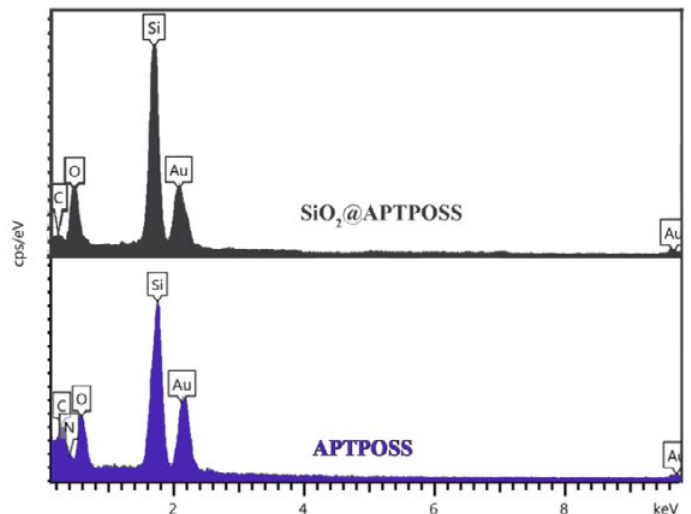
Fig. 3. Energy dispersive spectroscopy for APTPOSS and nano-colloidal silica Fig. 3 . Energy dispersive spectroscopy for APTPOSS and nano-colloidal silica @APTPOSS